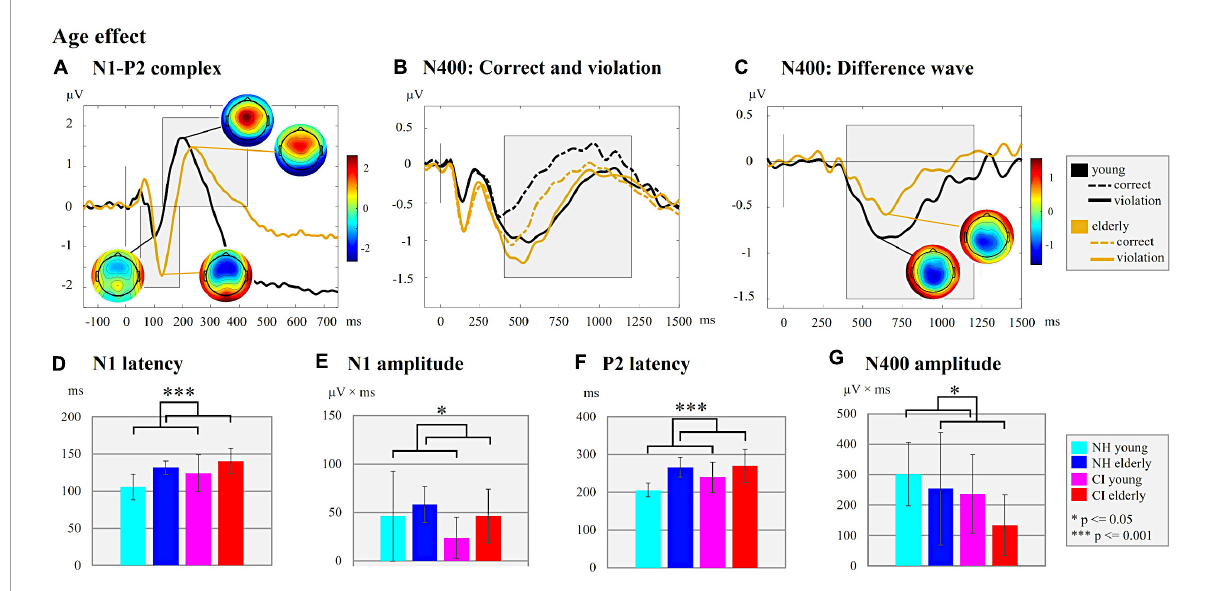
FIGURE5 Age effect. (A) N1-P2 complex. ERPs are shown for the two age groups (young/elderly) independent of background noise and of the hearing groups (NH/CI). The ERP topographies at the N1 (young individuals: 100 ms; elderly individuals: 126 ms) and P2 peaks (young individuals: 200 ms; elderly individuals: 236 ms) are given separately for each age group. Gray-shaded boxes indicate the N1 and P2 time windows for peak and latency detection. (B) N400: Correct and violation. ERPs are shown for the two age groups (young/elderly) independent on background noise and the hearing groups but separately for the different semantic context of the sentences (semantically correct vs. semantically incorrect/violation). The gray-shaded box indicates the N400 time window for the peak and latency detection of the supplementary analyses. (C) N400: Difference wave. The difference waves of the N400 ERP are shown for each age group (young/elderly) independent of the background noise and the hearing groups. For both age groups the ERP topographies at the N400 peaks are shown (young individuals: 622 ms; elderly individuals: 644 ms). The Gray-shaded box indicates the N400 time window for the peak and latency detection. (D) N1 latency. Bar plots with mean N1 latency (ms) for each subgroup independent of the background noise are shown. (E) N1 amplitude. Bar plots with mean N1 amplitude area ( µ V × ms) for each subgroup are shown. (F) P2 latency. Bar plots with mean P2 latency (ms) for the comparison between each subgroup independent of background noise are shown. (G) N400 amplitude. Bar plots with mean N400 amplitude area of the difference wave ( µ V × ms) for each subgroup are